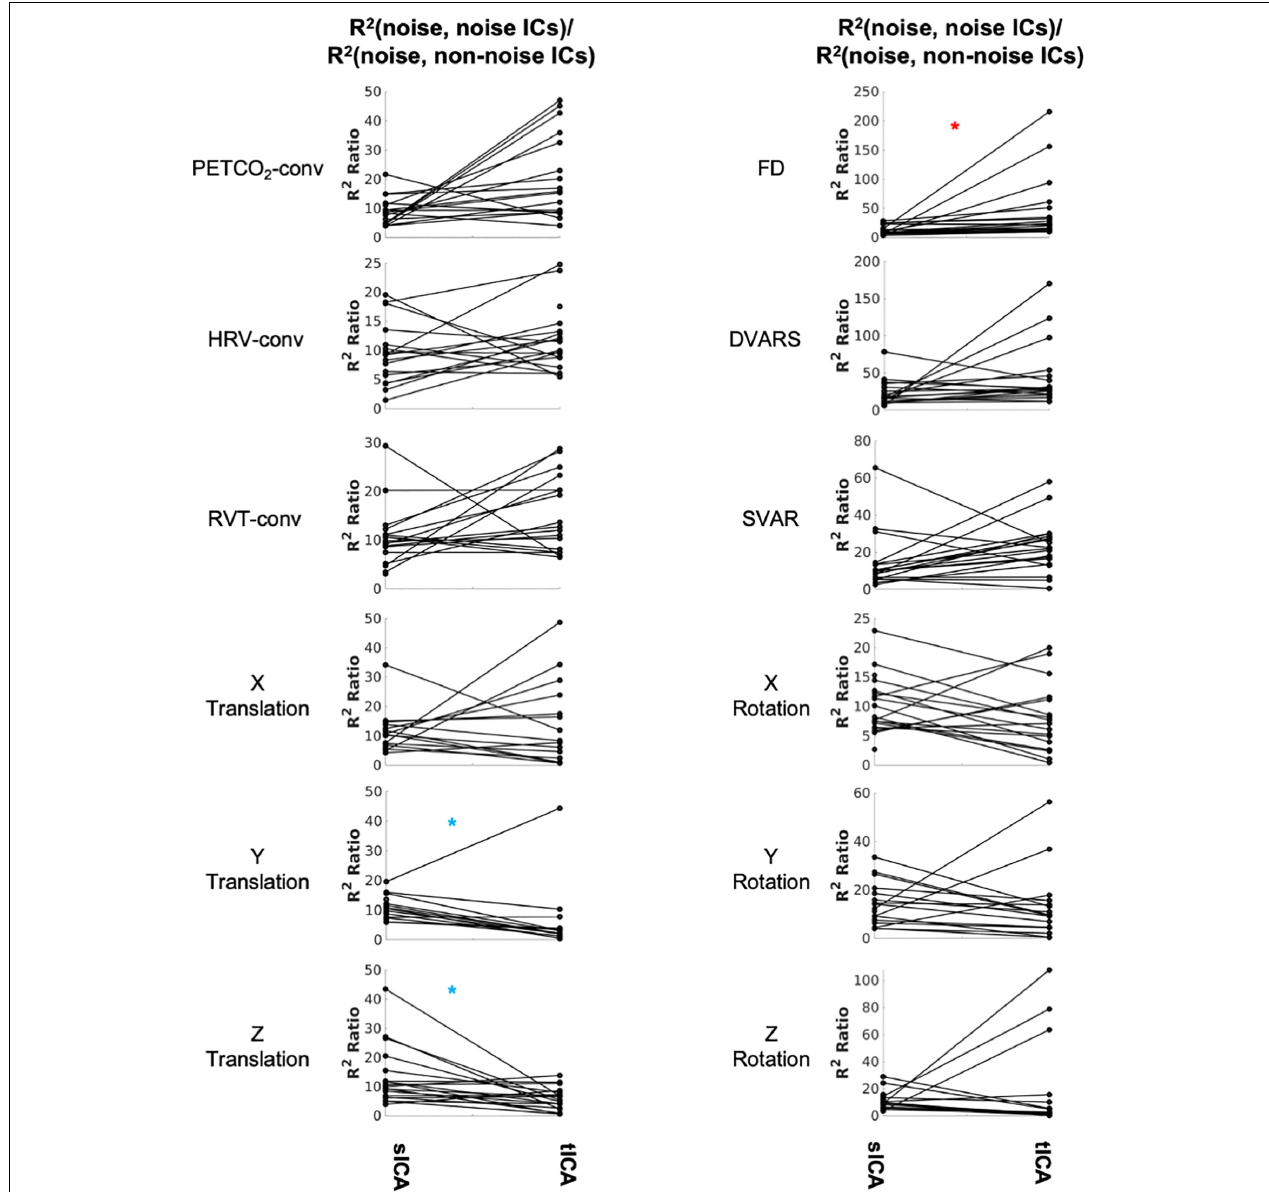
FIGURE 5 | Comparing sICA and tICA in identifying noise components. Each line represents one subject. Each plot depicts the noise-identification effectiveness ratio, i.e., the ratio of R 2 between noise markers and noise-correlated ICs over the average R 2 between the noise markers and non-noise-correlated ICs. Significantly higher values for sICA are indicated by the blue asterisk, whereas significantly higher values for tICA are indicated by the red asterisk. The significance of the changes is indicated in boldface in Supplementary Table 1